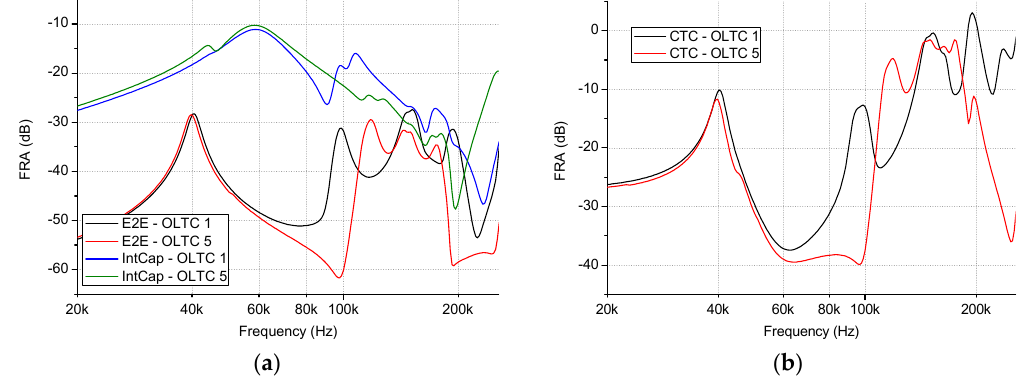
Figure 7. OLTC influence FRA test results for MF range: ( a ) E2E and IntCap; ( b ) CTC.